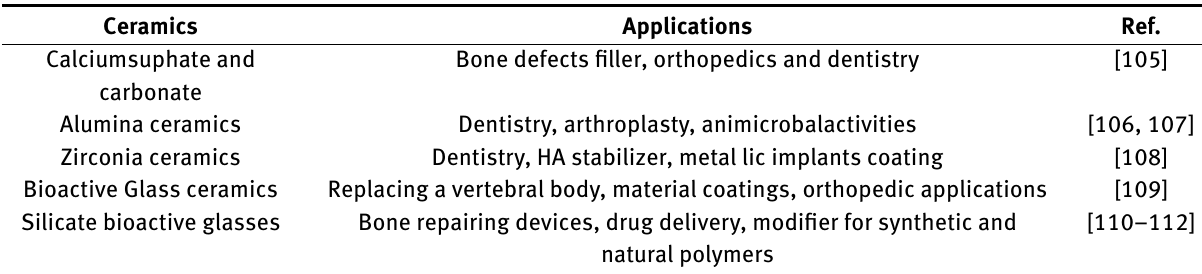
Table 8: Ceramics biomaterials used for biomedical application Ceramics